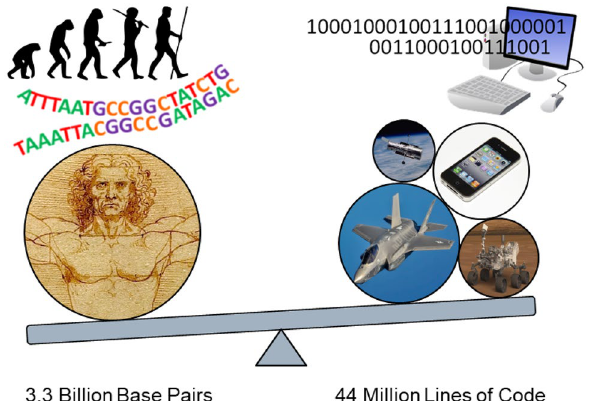
Figure 1. Comparison of complexity between the human genome and several major engineering systems. Image credits: Hubble and Mars Curiosity Rover: NASA/JPL-Caltech; iPhone: Yutaka Tsutano (CC BY 2.0), F-35: MSgt Donald Allen; March of Progress: M. GardeFerdinand (CC BY-SA